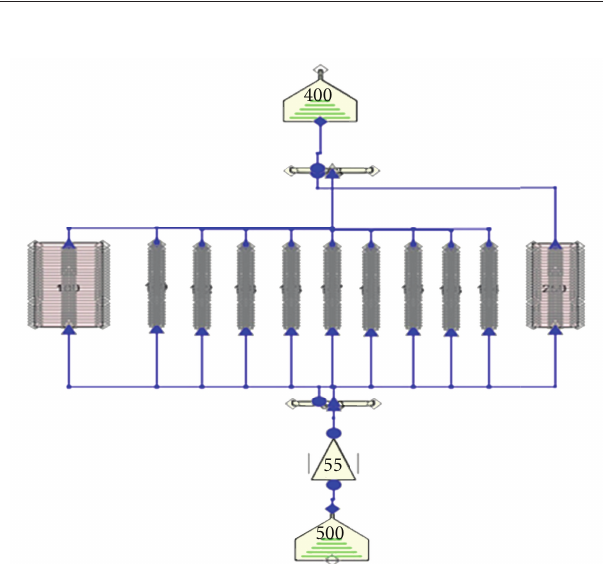
Figure 3: SNAP representation of the RELAP5